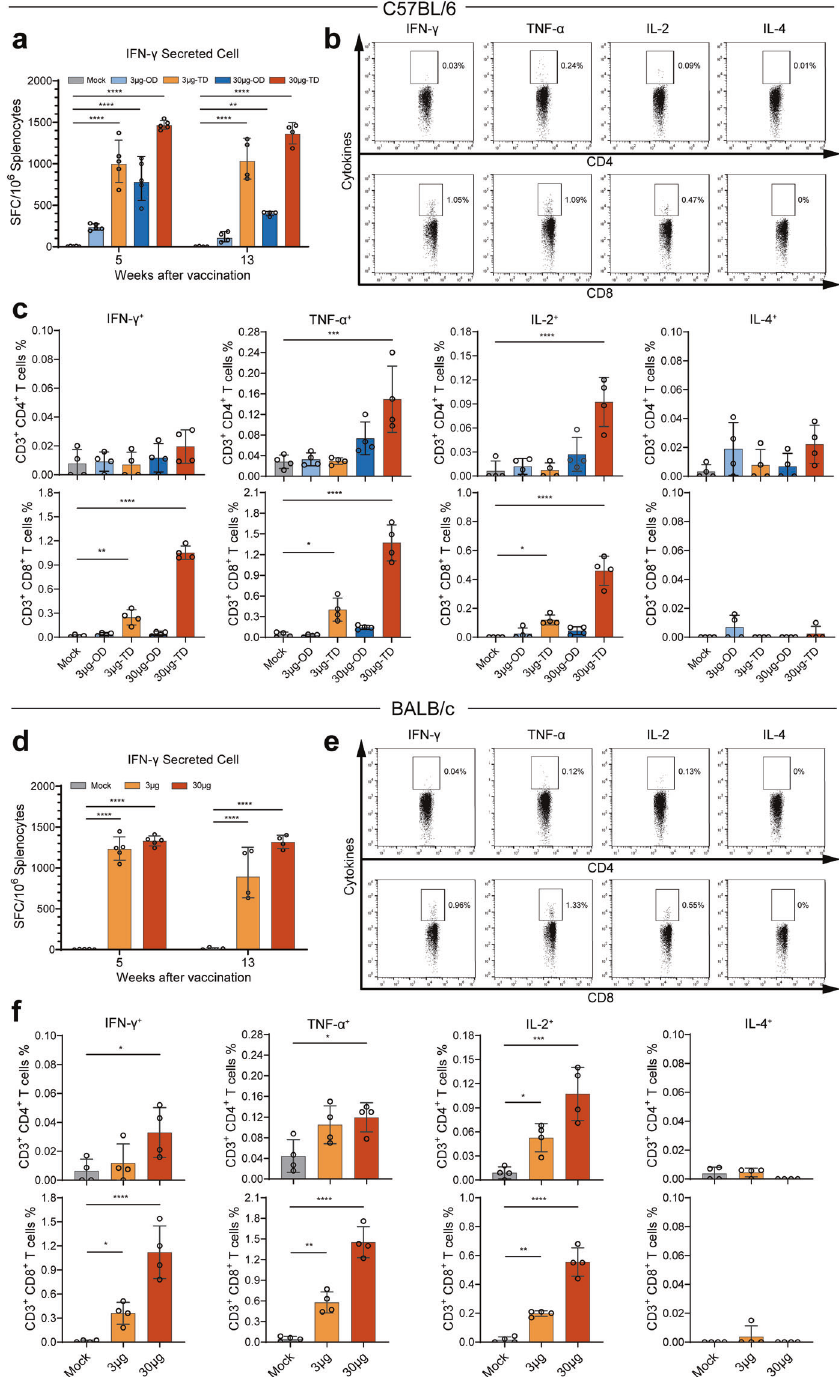
Fig. 4 Induction of predominantly Th1-biased T cell responses by SW0123. C57BL/6 mice received either an one-dose (OD) vaccination with 3 or 30 μ g SW0123 in week 0 or two-dose (TD) vaccinations with the same dosage in weeks 0 and 3. BALB/c mice were immunized twice with 3 or 30 μ g SW0123 in weeks 0 and 3. Mice in the mock group were administrated with empty vector as control. ( n = 5 in week 5; n = 4 in week 13). a , d Splenocytes were isolated 5 and 13 weeks after the fi rst vaccination. Following stimulation with S protein overlapping peptides for 20 h, IFN- γ -producing T cells were quanti fi ed with an ELISpot assay. b , c , e , f Splenocytes isolated 13 weeks after fi rst vaccination were stimulated with S protein overlapping peptides for 6 h, and Spike speci fi c cytokine-producing CD4 + and CD8 + T cells were measured with an